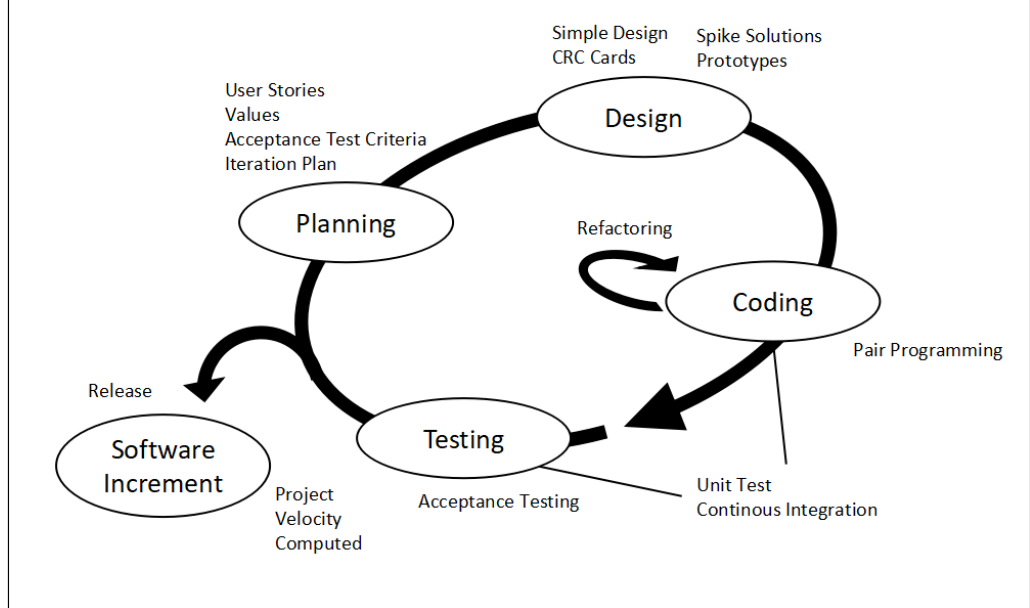
Figure 1. XP Methodology (Suryantara, et al.,